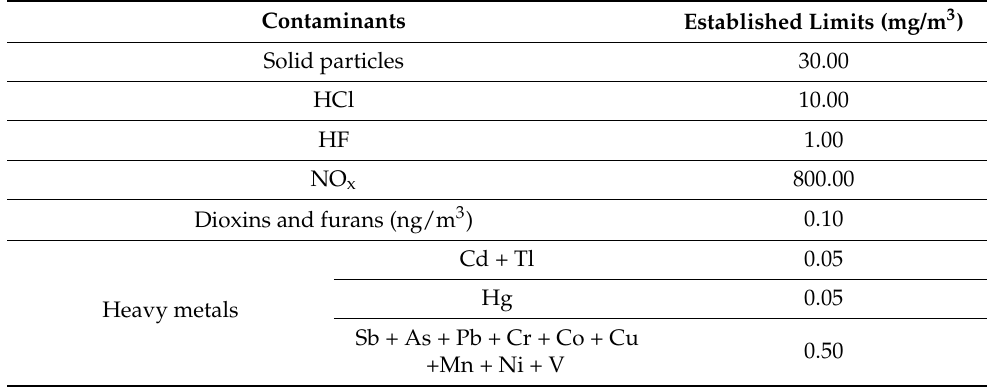
Table 2. Emission limits